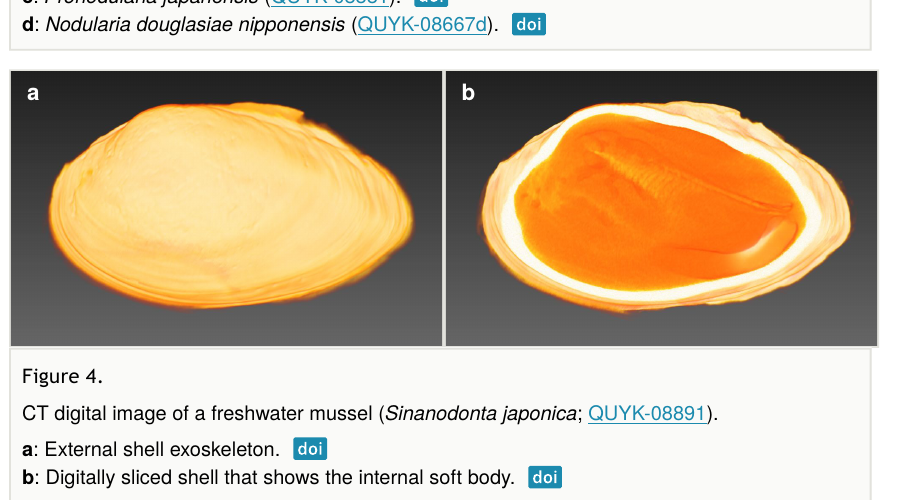
Figure 4. CT digital image of a freshwater mussel ( Sinanodonta japonica ; QUYK-08891). a : External shell exoskeleton. b : Digitally sliced shell that shows the internal soft